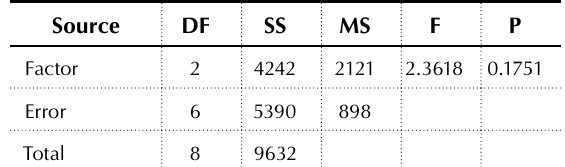
Table 8. ANOVA test results